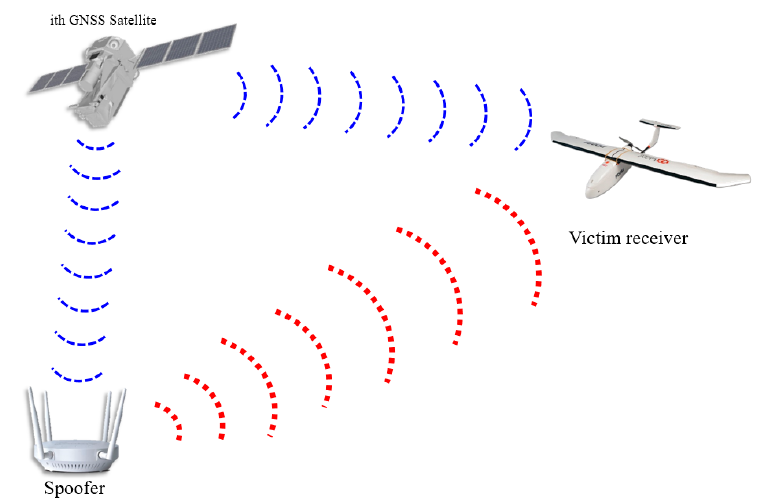
Figure 1. Illustration of a spoofing scenario.